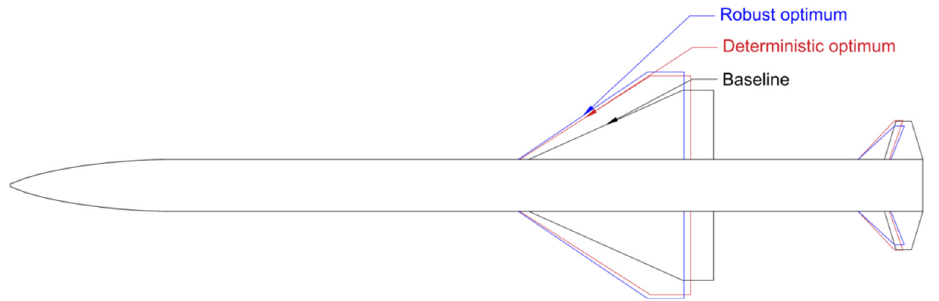
Figure 16. Three aerodynamic shape schemes of vehicle. Table 7. PCE and MCS of different